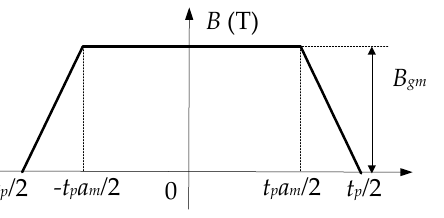
Figure 7. The equivalent trapezoidal wave model of air-gap flux density of the PMECC with non- slotted CR.